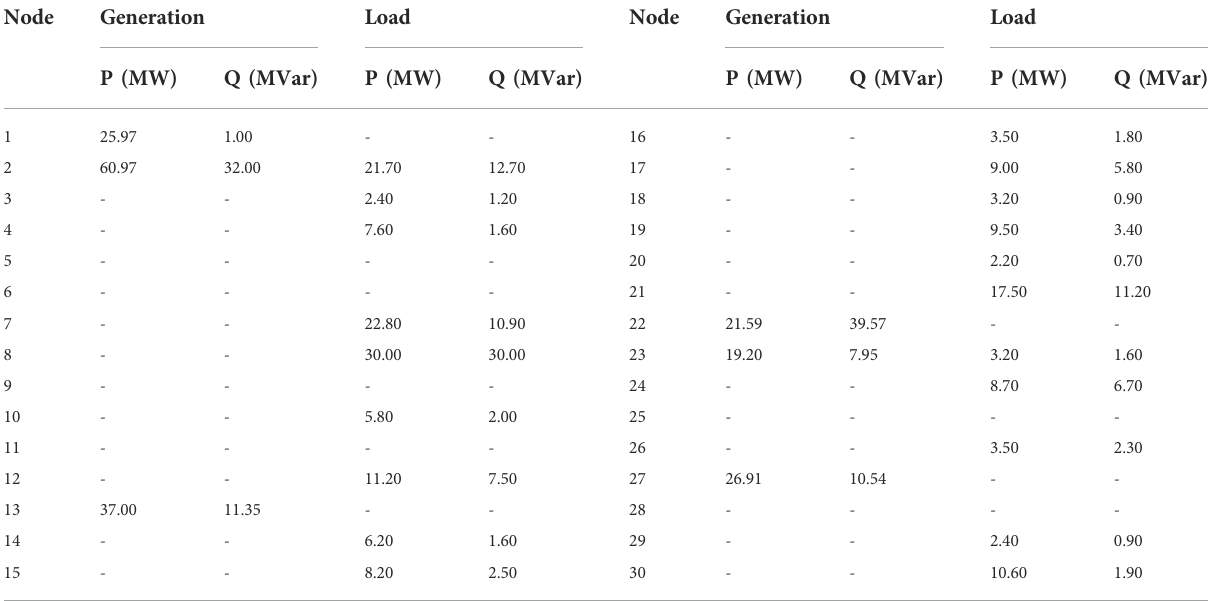
TABLE 3 The initial grid parameters of the IEEE-30 system.